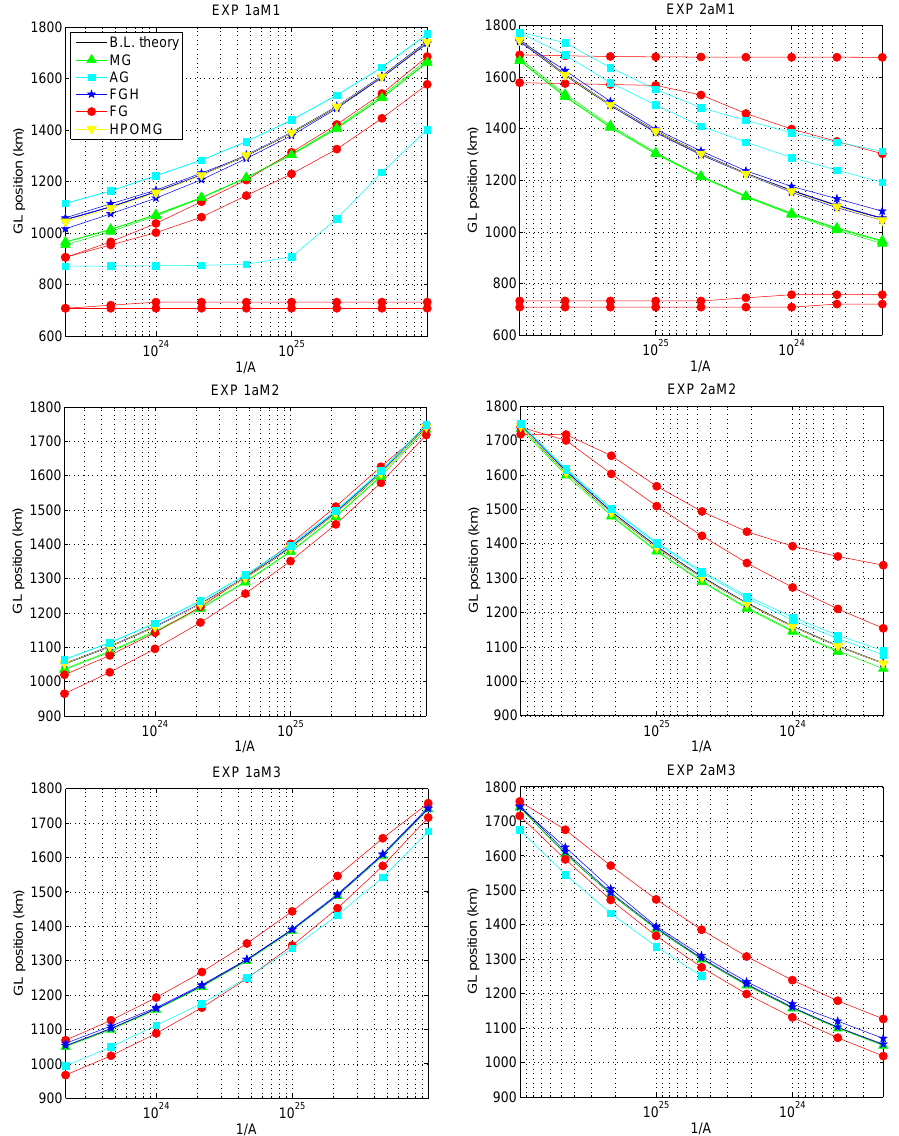
Fig. 3. Steady state grounding-line positions for advance (left) and retreat (right) as a function of ice viscosity ( A − 1 ) for Mode M1 (top), Mode M2 (centre) and Mode M3 (bottom). Colour coding according to model type: MG = moving grid, AG = Adapted grid, FG = fixed grid, FGH = SSA-H fixed grid with heuristic rule, HPOMG = MG using high polynomial-order finite difference stencils at the grounding line. The solution according to the boundary layer theory (Schoof, 2007a) is given as a black line (inside the FGH and HPOMG cluster).